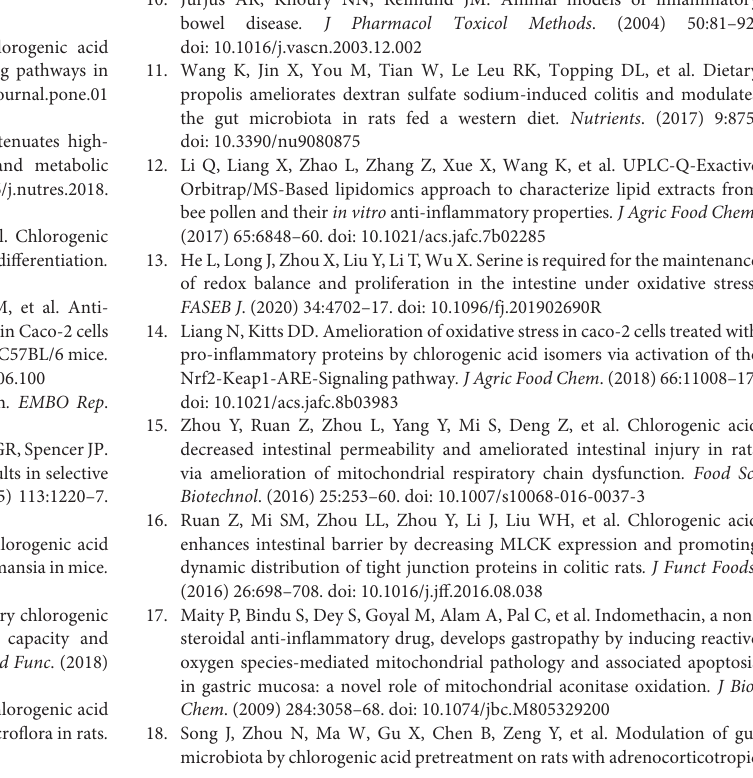
Supplementary Figure 1 | A full image of Figure 2E